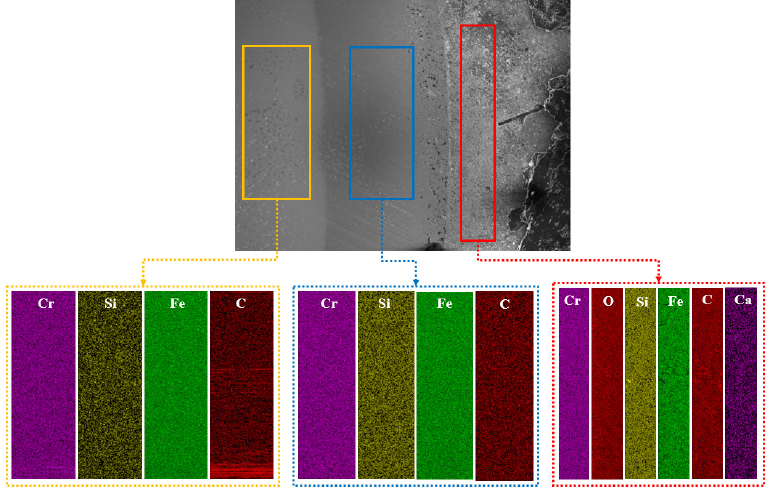
Figure 10. EDS of the front-end bearing’s rolling element wear delamination (serviced).